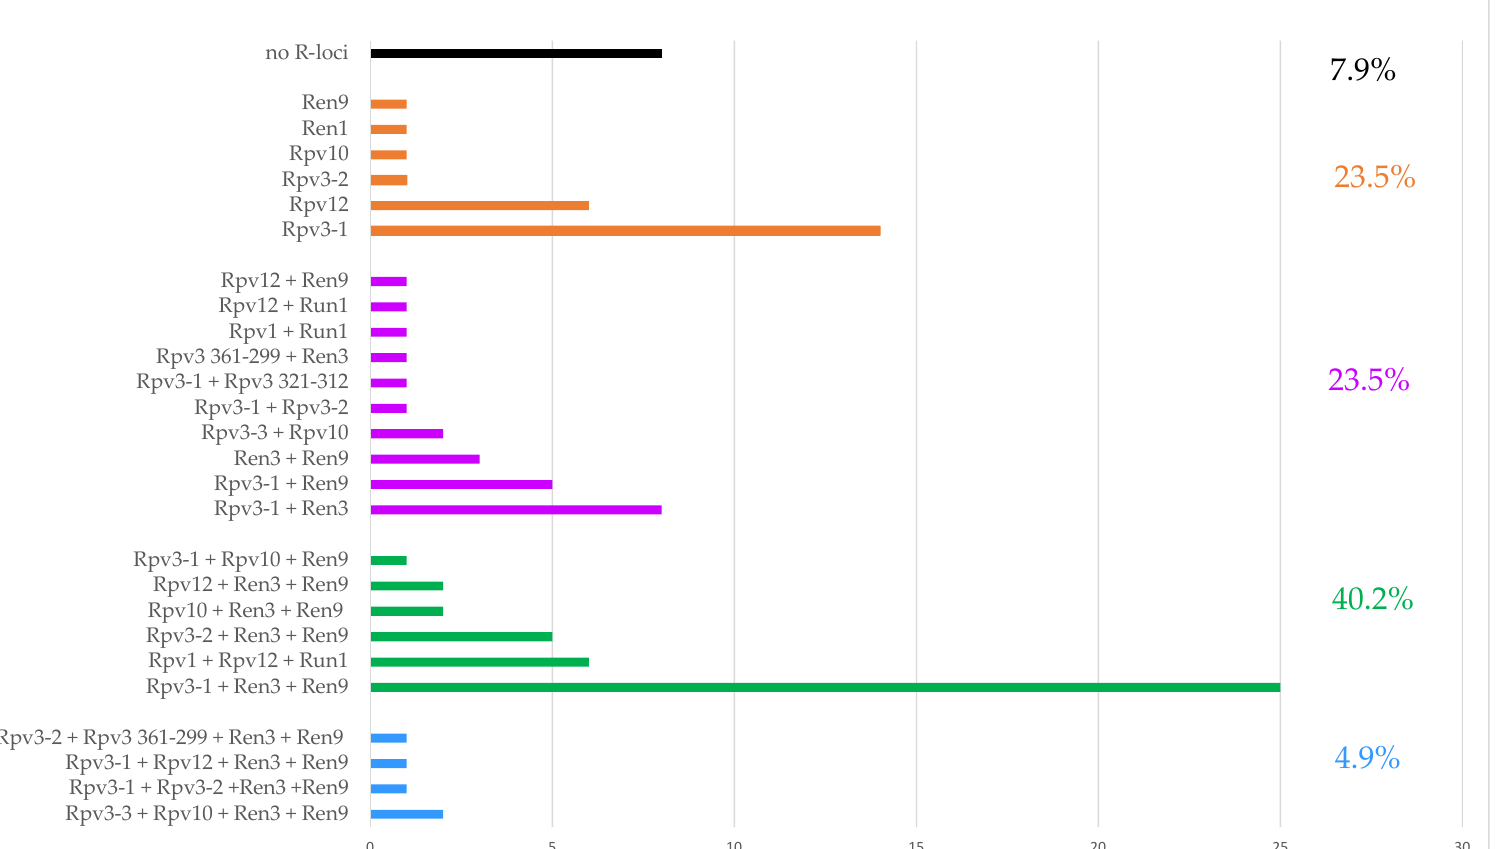
Figure 2. Grouped bar chart showing the percentual of accessions with single resistance locus, combination of two, three and four resistance ( R ) loci and absence of any studied R -locus. Rpv : Resistance to Plasmopara viticola ; Run : Resistance to Uncinula necator (from Muscadinia spp.); Ren : Resistance to Erysiphe necator (from Vitis